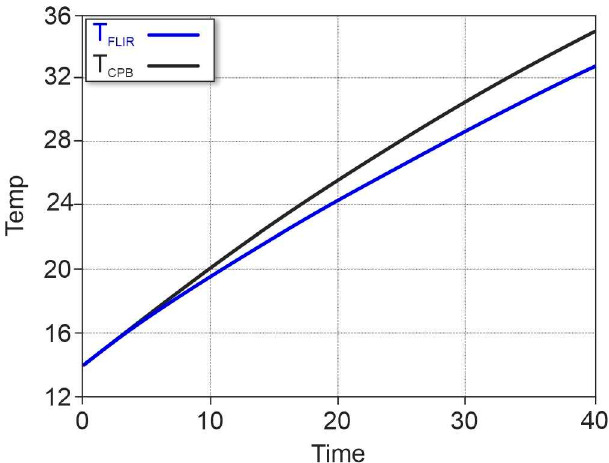
Figure 6. Input temperature data used in the process of simulating: T CPB— temperature value in the patient’s esophagus; T FLIR— myocardial surface temperature measured with FLIR thermal imagers.